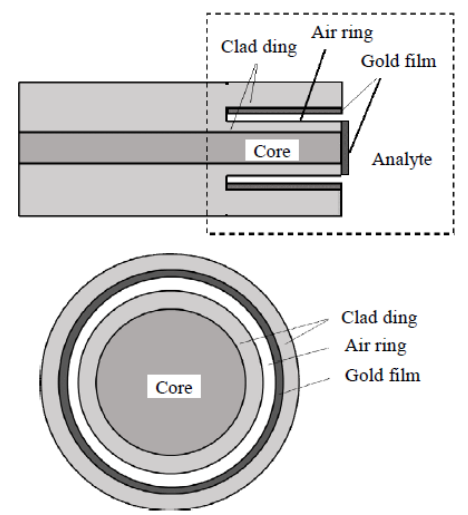
Fig. 1 Cross-sectional structure of the SPR sensor head based on optic fiber